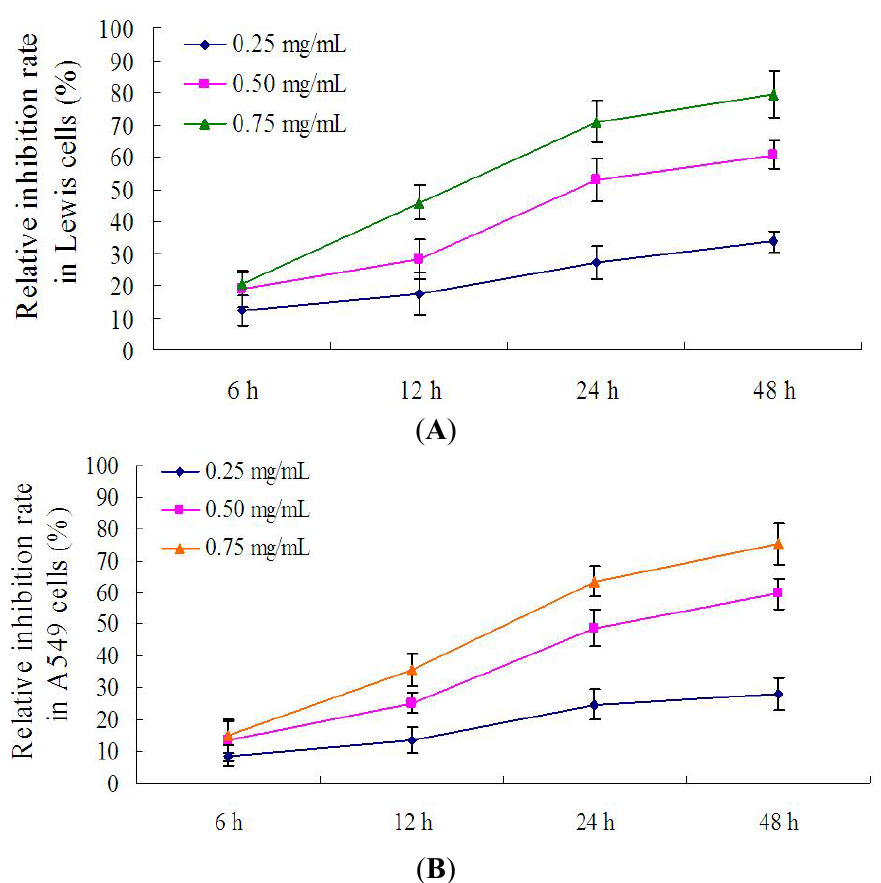
Figure 5. The inhibition of PRS on the proliferation of Lewis cells and A549 cells at different time points. Lewis cells and A549 cells were treated respectively with PRS (0.25, 0.50 and 0.75 mg/mL) at 6, 12, 24 and 48 h. The relative inhibition rate was calculated according to the OD values by MTT assay ( n =